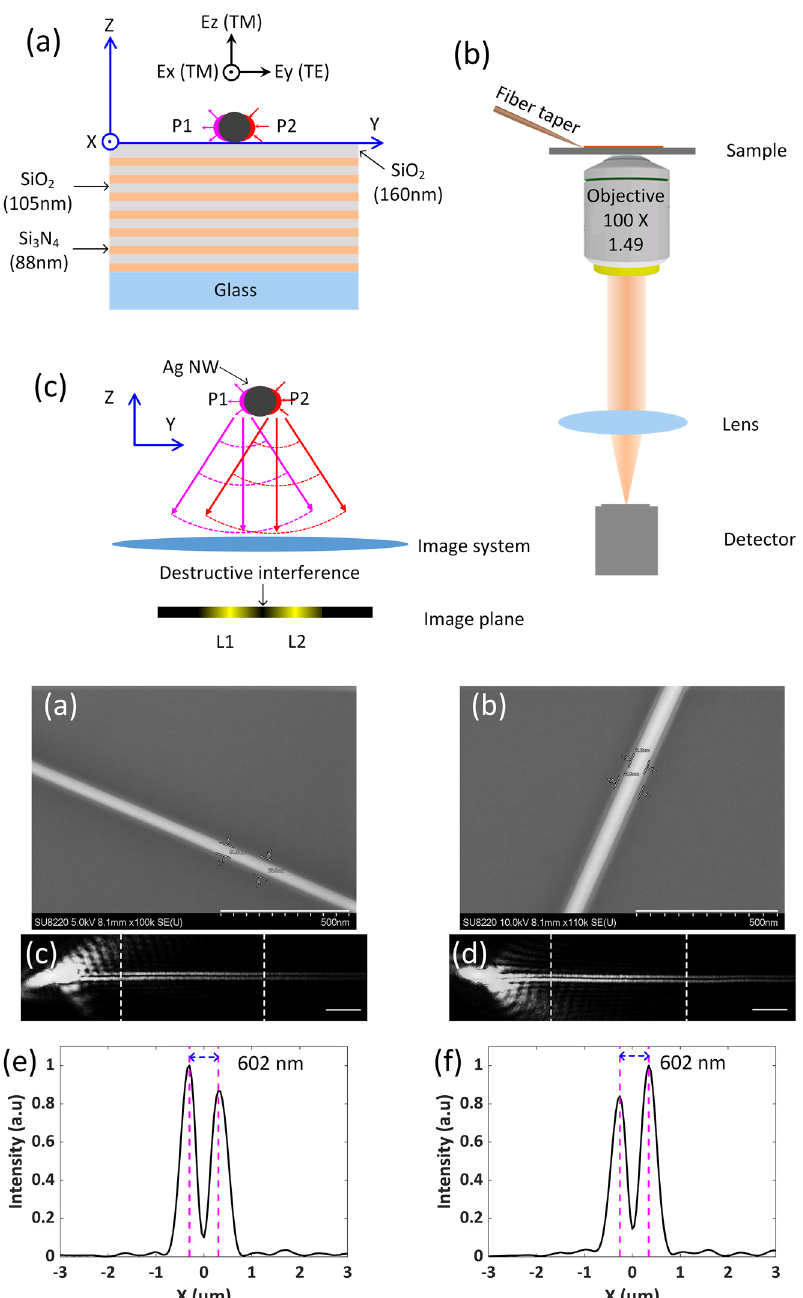
Figure 2: The images of SPs propagating along an Ag NW in the far-field. ThediameteroftheAgNWisabout40nmin (a, c, e),andis about 60nm in(b, d,f).(a, b) SEM images of the representative Ag NWs. The length of scale bars is 500 nm. Ag NWs are coated with a polymer cladding layer (thicknessofabout15nm).(c,d)Theimages of the SPspropagatingalongan Ag NW.The length of scale bars is 5 μ m. (e, f) The corresponding average intensity pro fi les perpendicular to the Ag NW in the area between the white dashed lines in (c, d). The distance between two peaks is 602 nm in both bright lines can be observed in the far- fi eld although the two plasmonic fi elds are separated less than 100 nm. The profiles of the real part for three electric field components (Ex, Ey and Ez) across the center of the Ag NW were plotted in Figure 3(b). From those pro fi les, we fi nd that the value of Ex (and Ez) component on one side-wall of the Ag NW is opposite to that on the other side-wall and the values of Ey component on the two side-walls are the same. It means that Ex (and Ez) component on the two side-walls of the Ag NW is out-of-phase whereas Ey component is in-